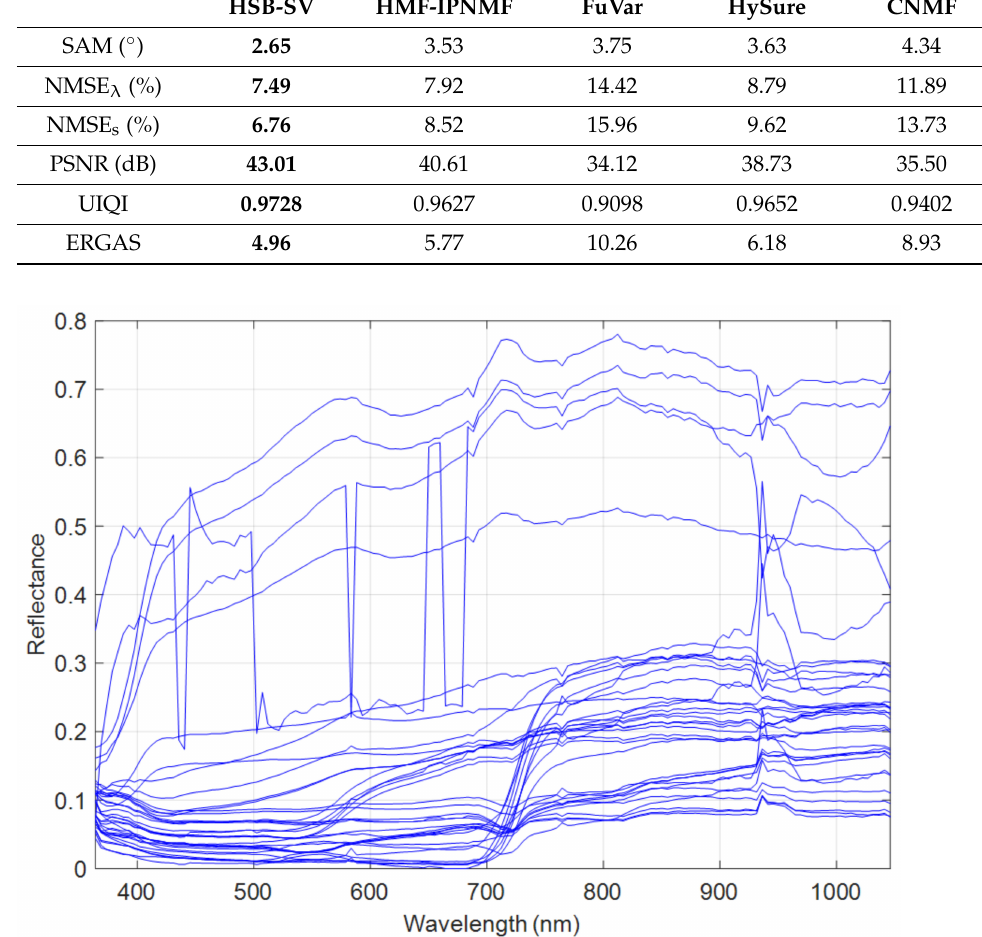
Figure 3. Extracted spectral library from the synthetic data by